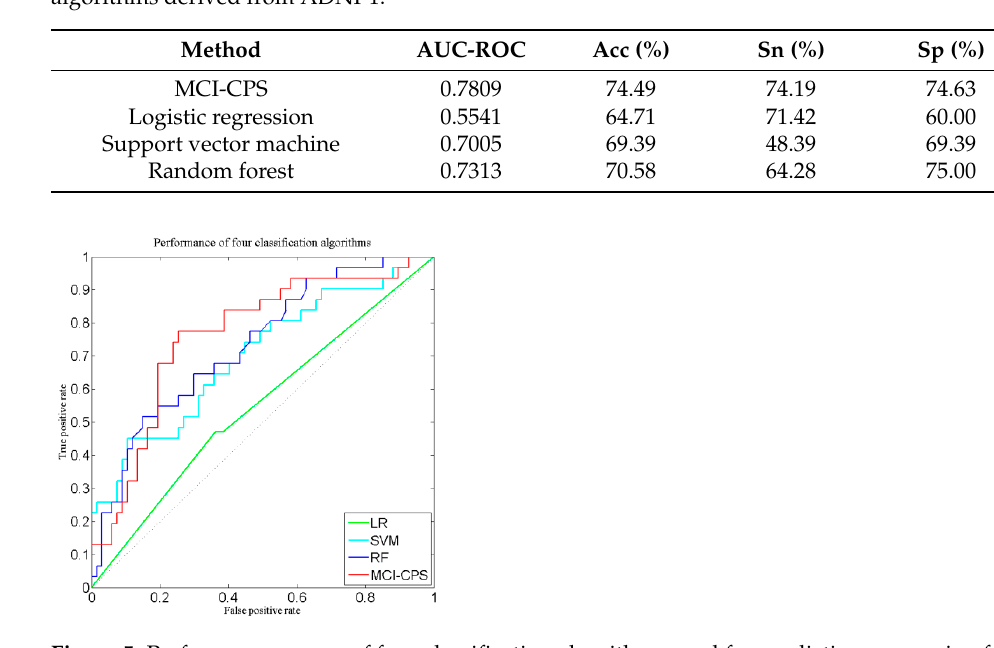
Figure 5. Performance curves of four classification algorithms used for predicting conversion from MCI to AD. Red line indicates VBpMKL, blue line indicates random forest, cyan line indicates SVM and green line indicates logistic regression.